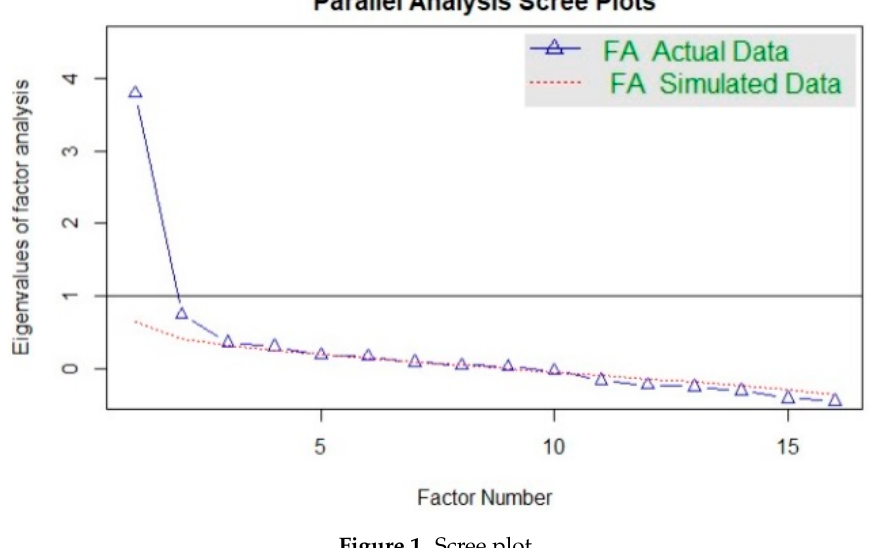
Table 3. Exploratory factor analysis (EFA) based on the polychoric matrix using principal axis and varimax rotation.